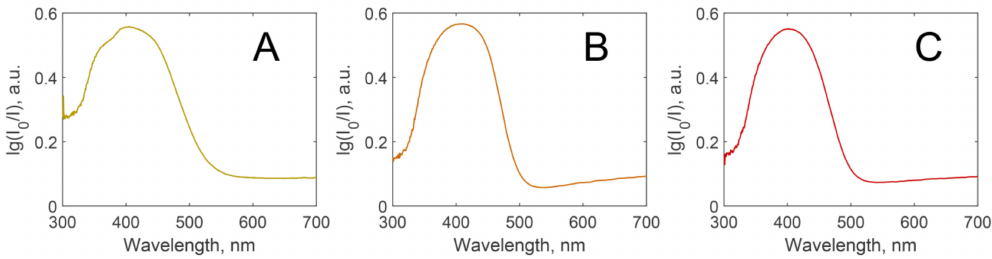
Figure 2. Diffusive reflectance spectra of HNT-NH 2 -CdS ( A ); HNT-Azine-CdS ( B ); and HNT-Azine-Cd 0.7 Zn 0.3 S ( C ). Spectra were registered using pristine halloysite as a reference.